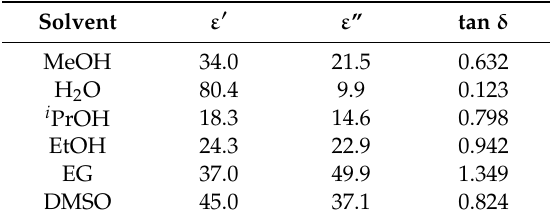
Table 1. Dielectric constants ( ε (cid:48) ), dielectric losses ( ε ”) and loss tangents (tan δ = ε ” / ε (cid:48) ) of the various solvents (MeOH, H 2 O, i PrOH, EtOH, EG and DMSO). Solvent ε (cid:48) ε ” tan δ MeOH